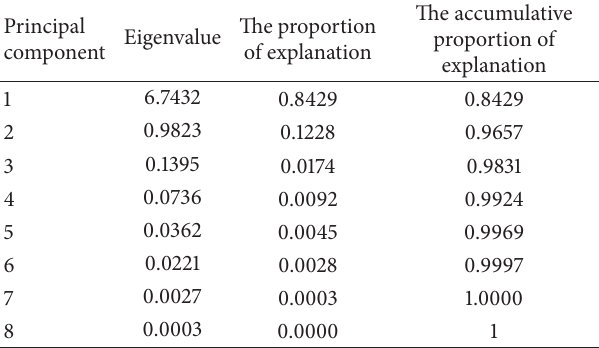
Table 1: Principal component analysis